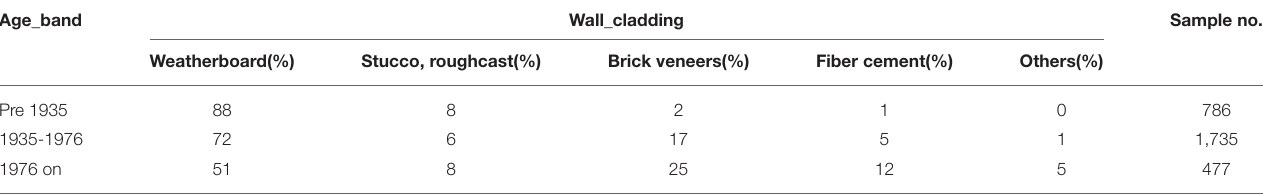
TABLE 7 | Distribution of wall cladding types in various age bands. Age_band Wall_cladding Sample no.